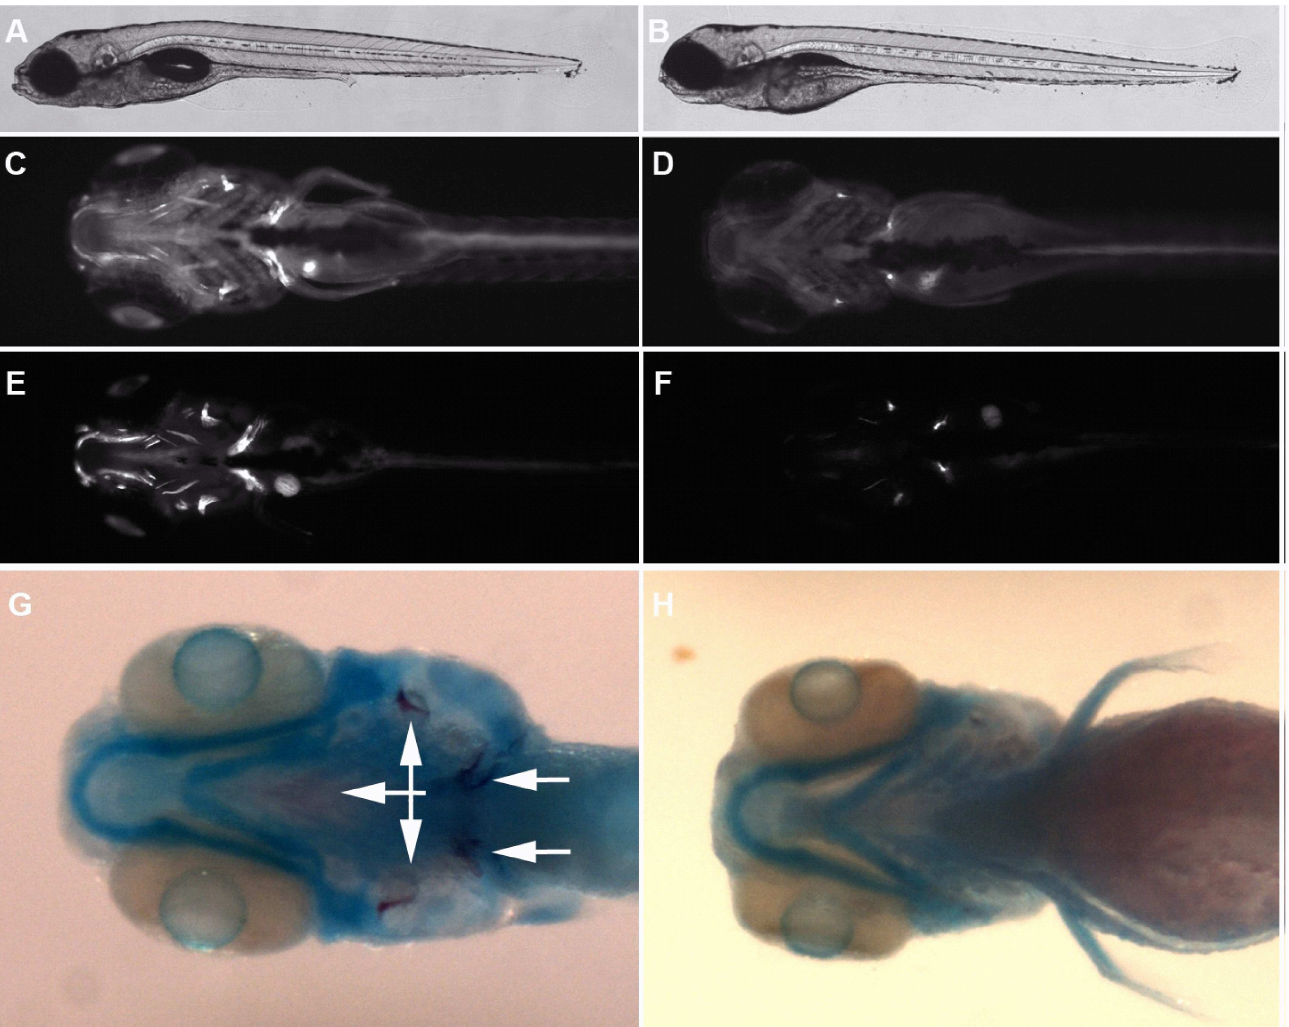
Fig 2. Bone but not cartilage cells are defective in atp6v1h -deficient zebrafish. ( A-B ) shows an image of a 6 days post fertilization(dpf) wild type and mutant embryo with relatively normal gross morphology. ( C-F ) Day 6 and 8 wild type and mutant embryosshowingreductionin bone detected by calceinstaining (ventral view, bright fluorescentstains indicatecalcifiedbone). In ( G-H ), doublestainingfor cartilageand bone demonstrate reduction of mineralized bone (dark purple, arrows) but not cartilage(blue). A, C, E and G are wild type. B, D, F, and H are